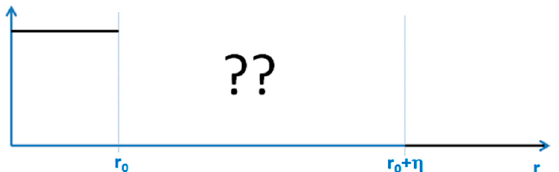
Figure 3. Nothing is a-priori known about the shape of the functions in the small transition width between the two states. It should be noted that two state systems have a major importance also in quantum mechanical systems and